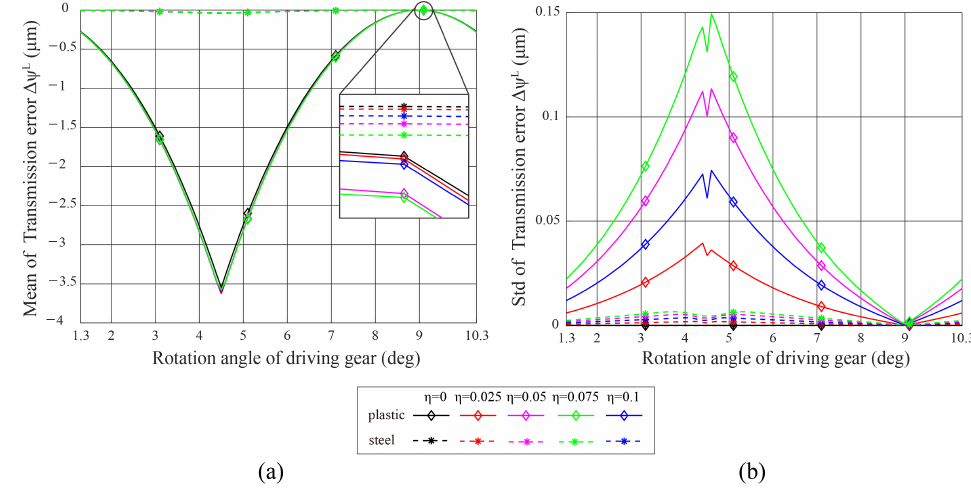
Figure 14. ( a ) Mean and ( b ) standard deviation (std) of transmission error under loaded condition. When the uncertainty of the material properties ( η ) increases, there is no machining error or pitch error ( (cid:101) = 0, e p = 0 )